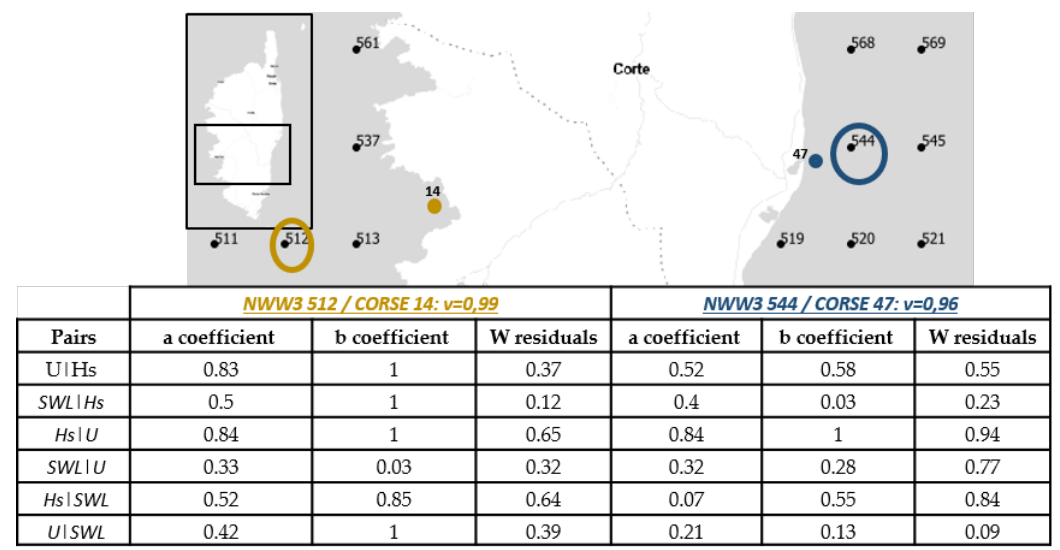
Figure A4. Wave roses; and Dp(°) plotted against Hs(m) for three offshore points. The red dots and red circles indicate the wave directions, which could most affect the coastline for extreme conditions regarding the coast morphology.